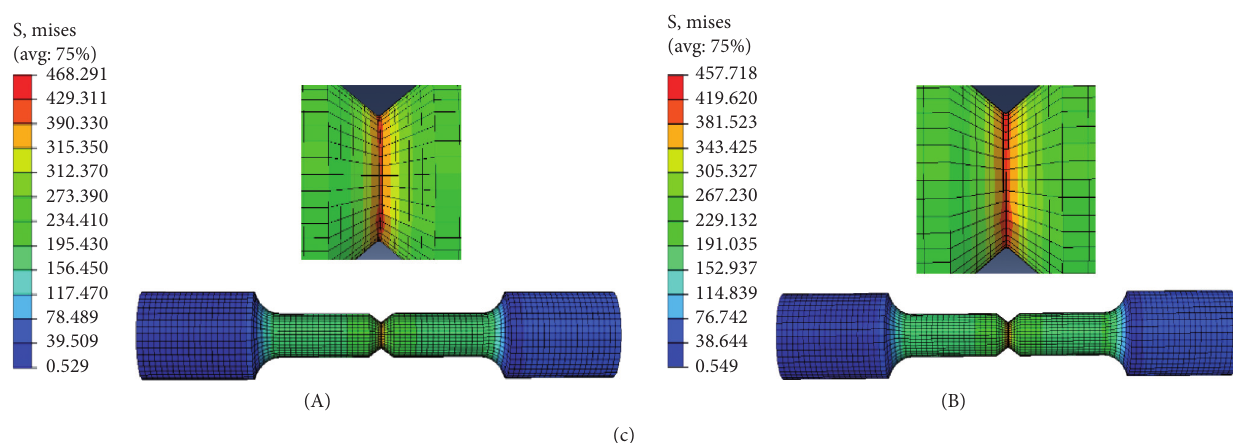
Figure 6: Mises stress figures of different notch root radii. (a) Symmetric 30: notch root radius (A) 0.1mm and (B) 0.15 mm. (b) Symmetric 45: notch root radius (A) 0.1mm and (B) 0.15mm. (c) Symmetric 60: notch root radius (A) 0.1mm and (B)